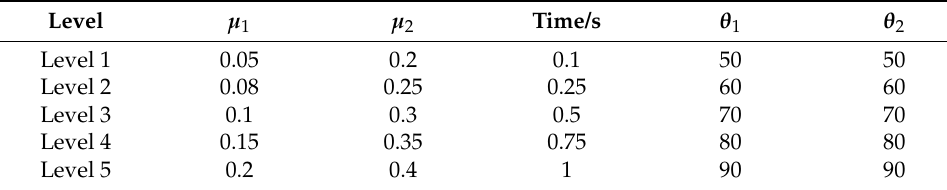
Table 2. Joint connection-strength-test factor level.